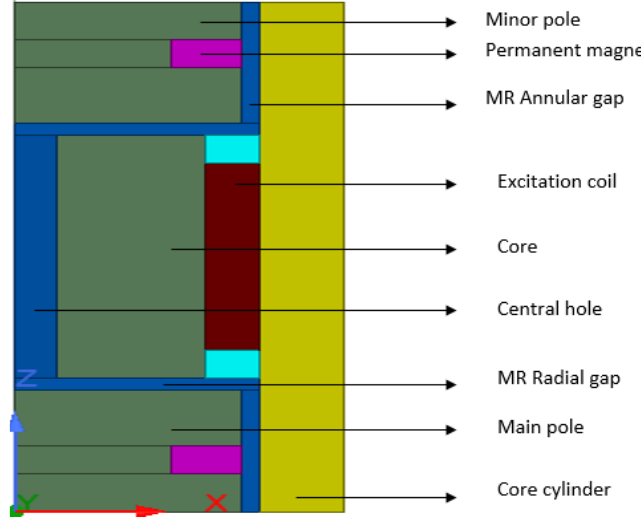
Figure 2. Axisymmetric model of the HARMRD.